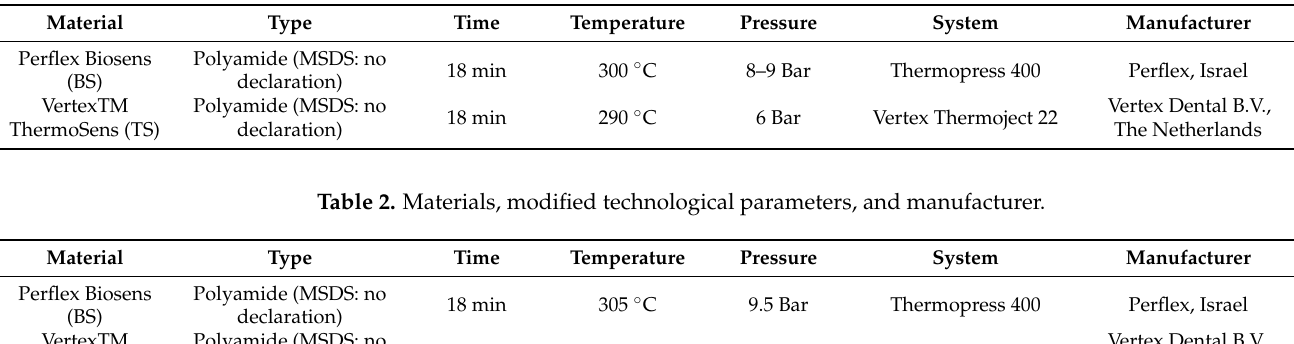
Table 2. Materials, modified technological parameters, and manufacturer.